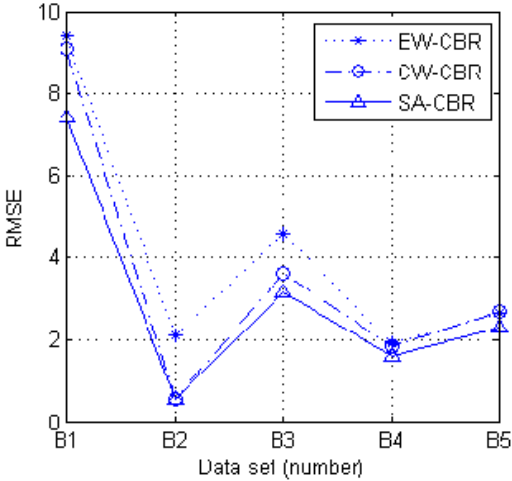
Figure 8. Results of the comparison of three CBR methods.